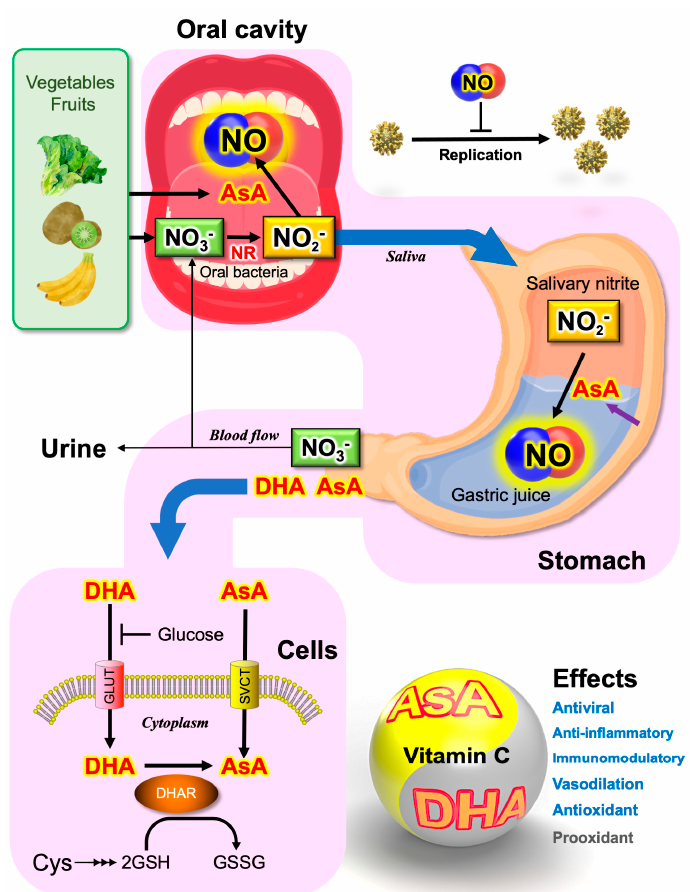
Figure 4. Possible functions of orally-taken ascorbate and nitrate in the prevention and mitigation of COVID-19. Plants (vegetables and fruits) contain abundant nitrate (NO 3 − ) and vitamin C ( L -ascorbate) in their tissues. When chewing those diets with saliva, NO can be generated by the reductive mechanism. Organic acids contained in fruits and vegetables facilitate the chemical production of NO in the oral cavity. The oral cavity harbors a huge diversity of symbiotic bacteria that can reduce the nitrate secreted from saliva glands to nitrite (NO 2 − ). If powdery vitamin C is taken orally, a high concentration of NO could be generated in the oral cavity by the reductive mechanism. When saliva, including nitrite, is mixed with gastric juice, similarly, chemical NO generation occurs. The strong acidity of the gastric juice facilitates chemical NO generation. NO 3 − is absorbed in the small intestine and is concentrated in the saliva glands. The vitamin C in plasma is incorporated into cells by sodium-dependent Vit C transporters (SVCTs) [20]. In parallel, dehydroascorbic acid (DHA), an oxidized form of vitamin C, is taken up through glucose transporters (GLUTs) [20]. Since glucose competes with DHA on transporters [163], vitamin C availability in cells may be limited in high sugar diets and high blood sugar conditions, a potential reason for the pathological severity of COVID-19 in diabetes patients [164]. Ascorbate and DHA show direct and indirect pharmaceutical effects that are sometimes opposed. AsA, L -ascorbic acid or vitamin C; DHAR, dehydroascorbic acid reductase; GSH, reduced form of glutathione; GSSG, oxidized form of glutathione; Cys, L -cysteine. Gastric juice acts as the first line of defense to avoid gastrointestinal infection by pathogens [165]. Its pH is near 1 (equivalent to 0.16 M HCl [166]). However, this strongly acidic pH can be measured only under fasting conditions. The pH may go up to a